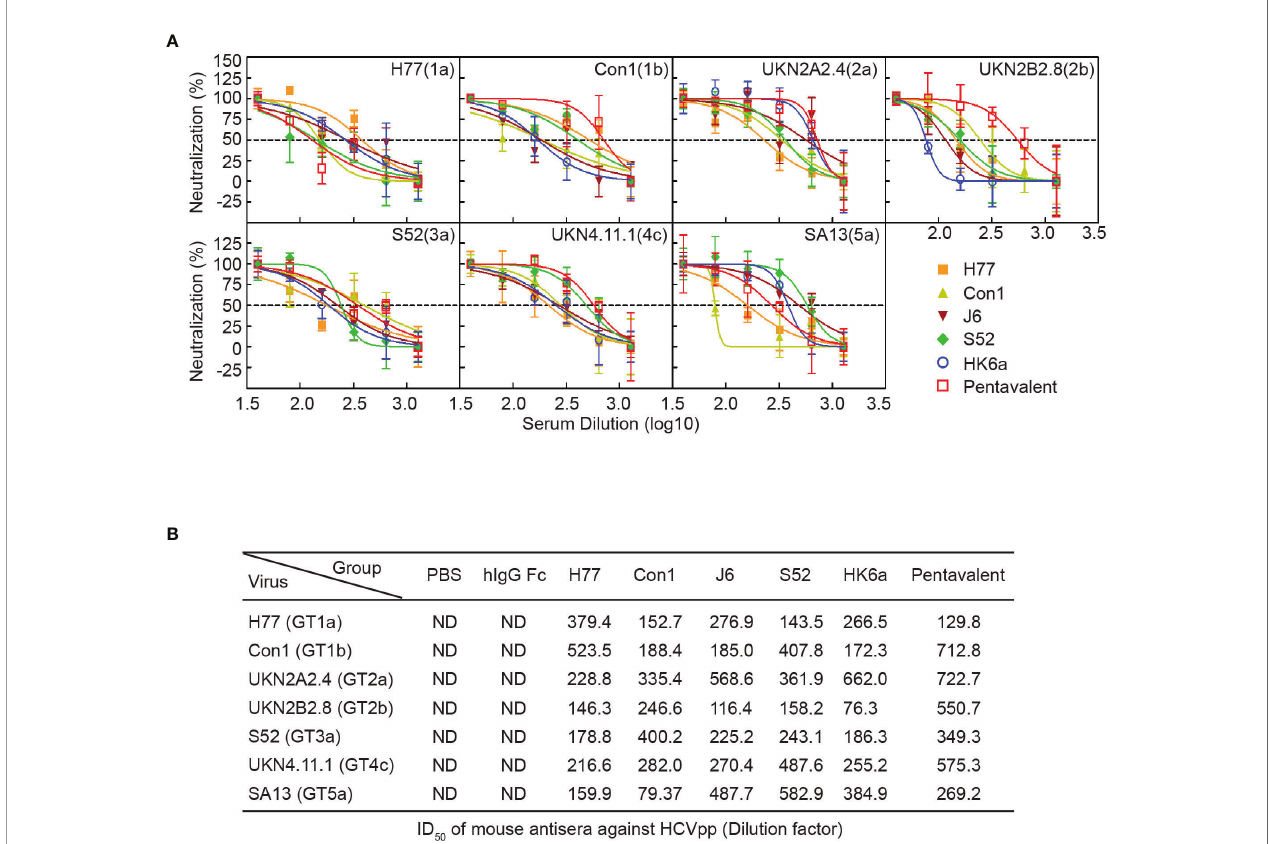
FIGURE 6 | Neutralization analysis of the pentavalent and monovalent Fc-E1E2 vaccines in mice. (A) Neutralization curve of the week 46 vaccinated sera. Sera from each group were serially diluted two times from 40 to 1280 for the neutralization test. The neutralization curves were fi tted by nonlinear regression. (B) ID 50 of antisera. ID 50 was de fi ned as the dilution of sera able to neutralize 50% of HCVpp infectivity, and the ID 50 values were calculated by GraphPad Prism. HCVpp, HCV pseudoparticles. ID 50 , 50% inhibitory